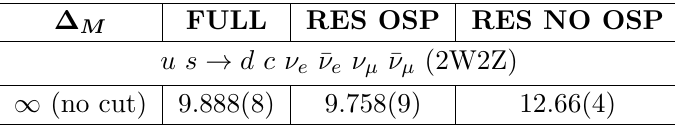
d c (cid:23) e (cid:22) (cid:23) e (cid:23) (cid:22) (cid:22) (cid:23) (cid:22) , for M (cid:23) M Z < (cid:1) M ( ‘ = e; (cid:22) ). ‘ (cid:22) (cid:23) ‘ (cid:0) ! j j > 20 GeV ; (cid:17) j < 5 : 5 ; M jj > 600 GeV ; (cid:1) (cid:17) jj > 3 : 6 ; M 4 ‘ > t j j j j